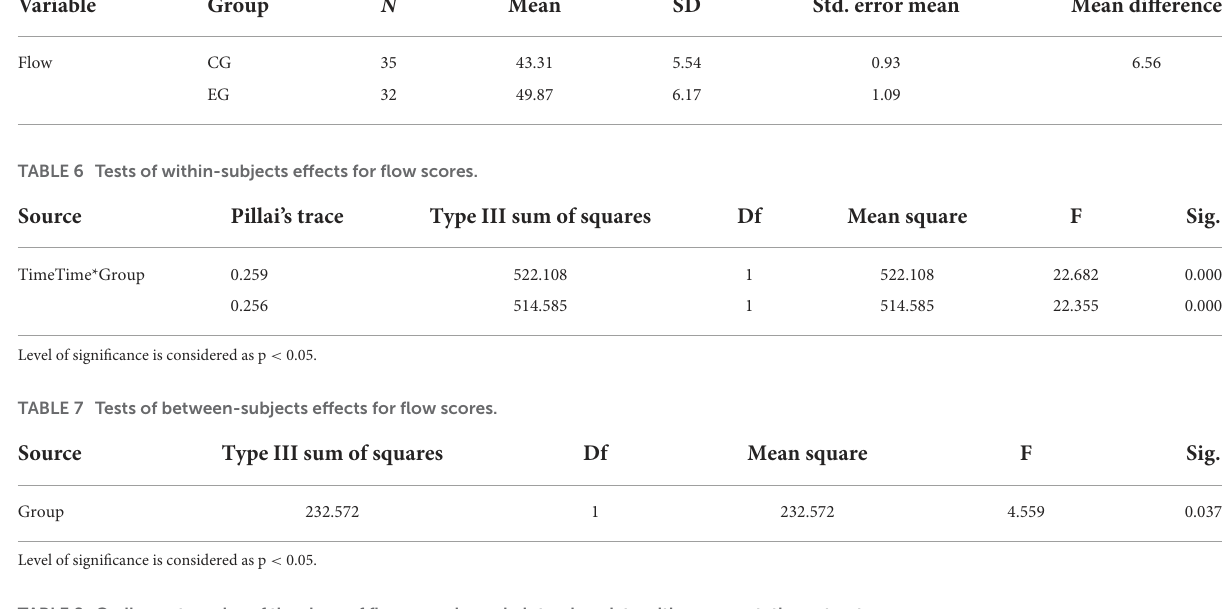
TABLE 8 Coding categories of the signs of flow experience in interview data with representative extracts. Category Representative